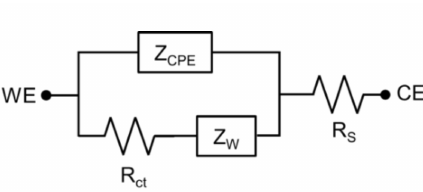
Figure 4. The representative equivalent model of a µ ECoG electrode. WE, working electrode; CE, counter electrode; Z CPE , constant phase element; Z W , Warburg impedance; R CT , charge transfer resistance; R S , solution